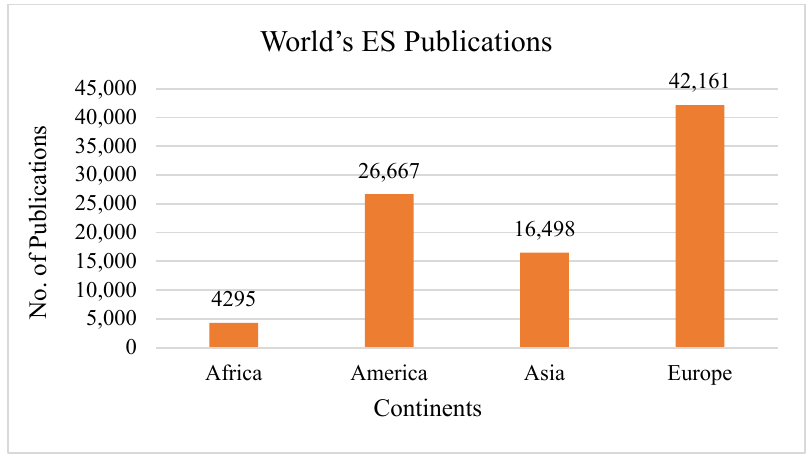
Figure 6. Trend of world’s ecosystem service publications.